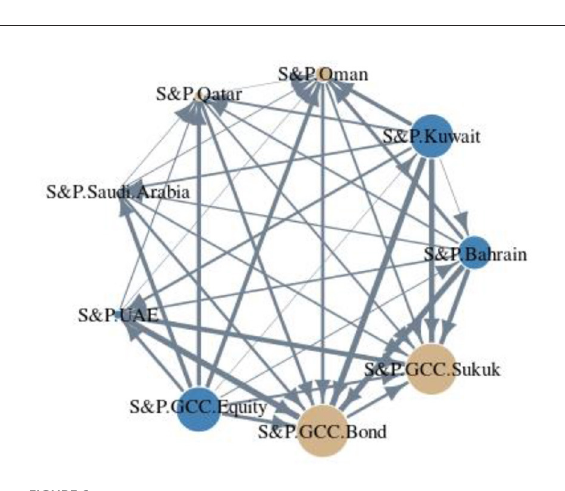
FIGURE6 Dynamic connectedness network plot. The of TVP-VAR approach network plot is displayed in this figure. The Blue nodes exhibit the net transmitter role of bond and equity market indices and yellow nodes illustrate the net receiver of the shocks. Vertices are the measures of weighted average net pairwise directional connectedness. The nodes size shows the weighted average net total directional